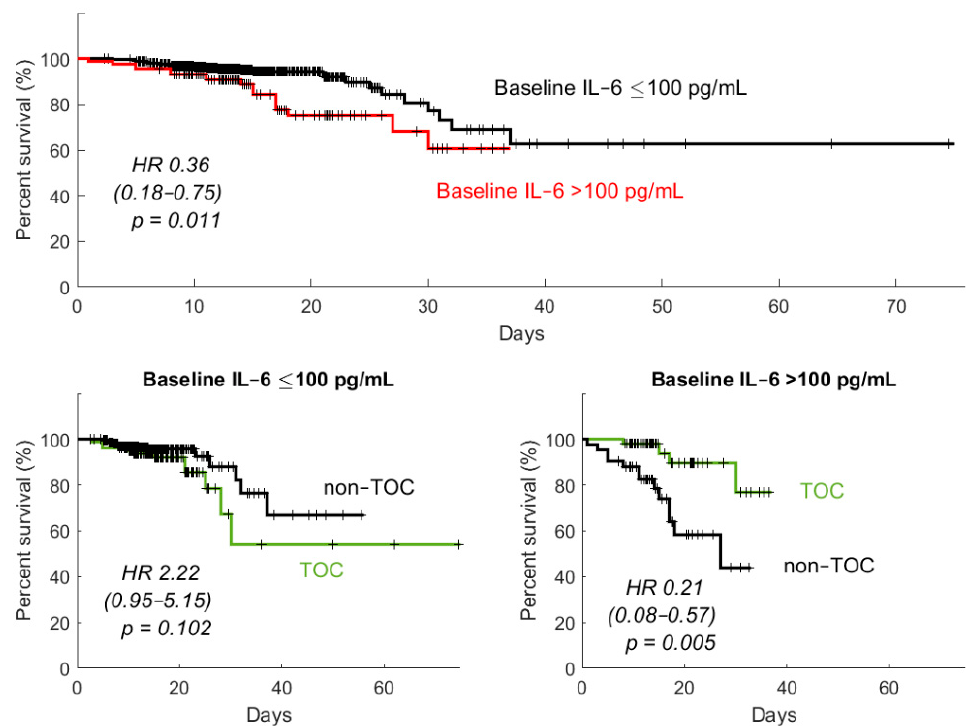
Figure 1. Kaplan–Meier graphs demonstrating the effect of tocilizumab versus no tocilizumab administration on patients’ survival depending on the obtained optimal threshold baseline serum concentration of interleukin 6. The hazard ratios (HR) and their 95% confidence intervals are provided as well as the log-rank test p-values. Table 3. Correlations between baseline serum IL-6 vs. selected clinical and laboratory indices. IL-6 Versus